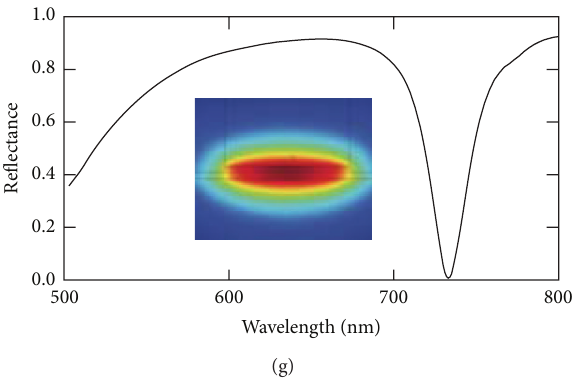
Figure 16: (a) Schematic of the metasurface-based absorber. (d) Physical model of the absorber, where the metasurface is described by its impedance. (b) Ideal impedance and retrieved impedance for the dispersive metasurface. (c, e) Absorption of the broadband (c) and dual narrowband (e) absorbers at different angles of incidence. (f) Schematic of the plasmonic nanocube based absorber. (g) Typical reflectance of a silver (Ag) nanocube. Figures are reproduced from (a)–(c) [114], (d, e) [37], and (f, g)